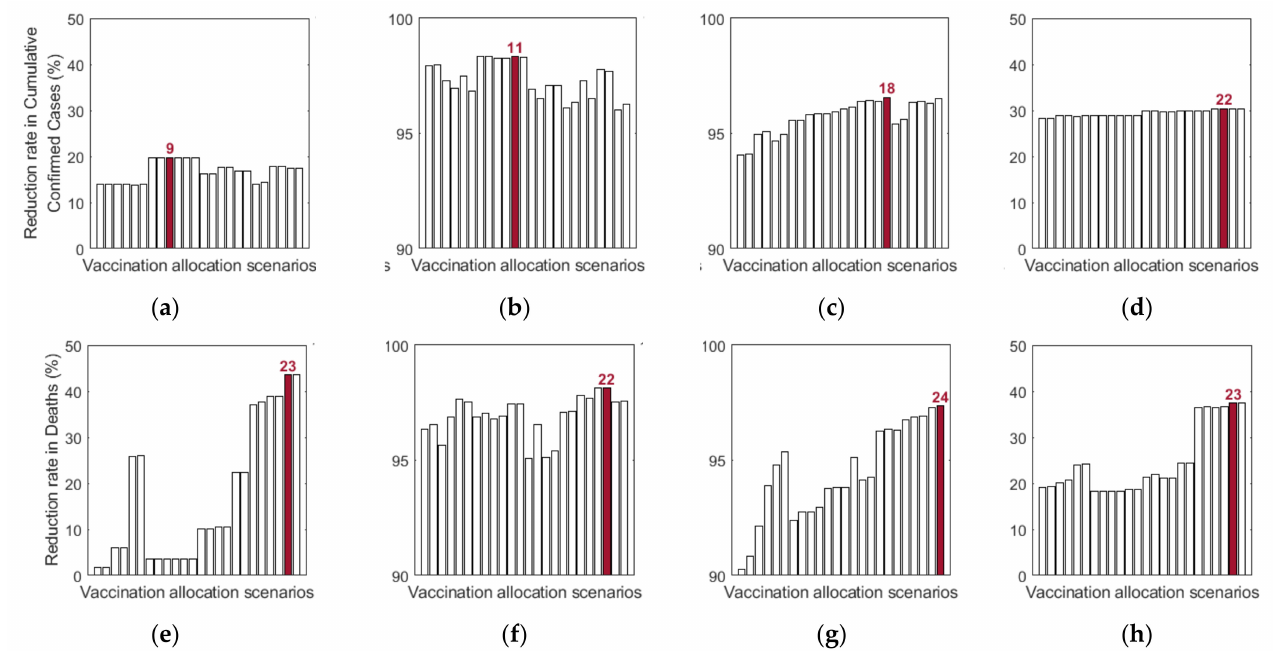
Figure 13. Impact of vaccination allocation scenarios on the reduction in cumulative confirmed cases and deaths for different SD levels: ( a , e ) 0, ( b , f ) 1, ( c , d ) 2, and ( d , h )